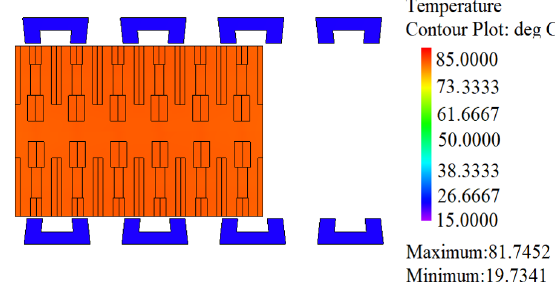
Figure 25. Temperature distribution of the